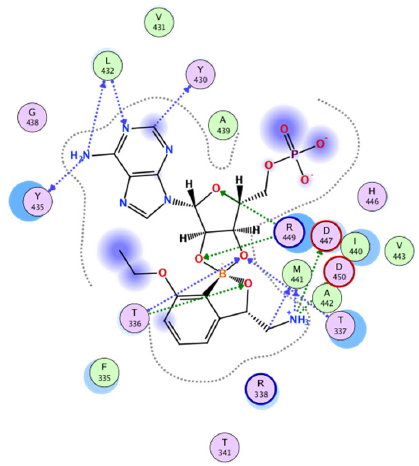
Figure 2. Ligand interaction diagram of Mtb H37Rv LeuRS and ( S )-3-(aminomethyl)-7-ethoxybenzo[c][1,2]-oxaborol-1( 3H )-ol in the form of the bivalent adduct with AMP (PDB ID: